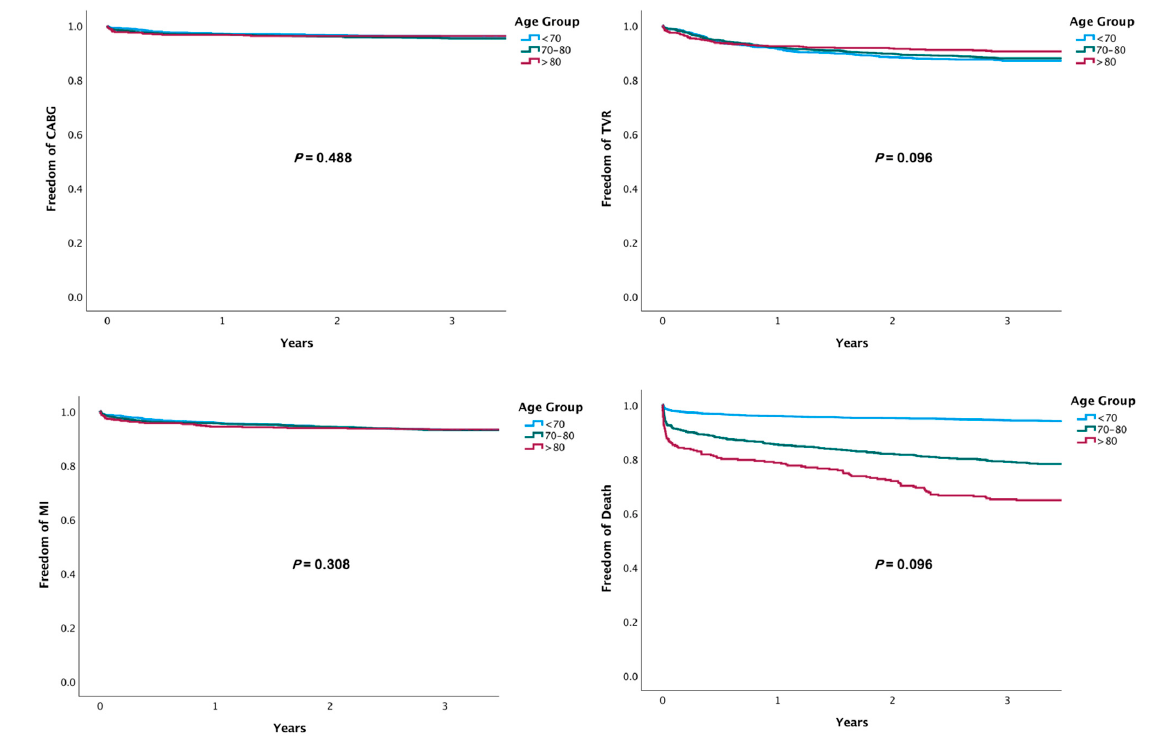
Figure 1. Kaplan–Meier curves of ischemic outcomes according to age. Table 1. Baseline